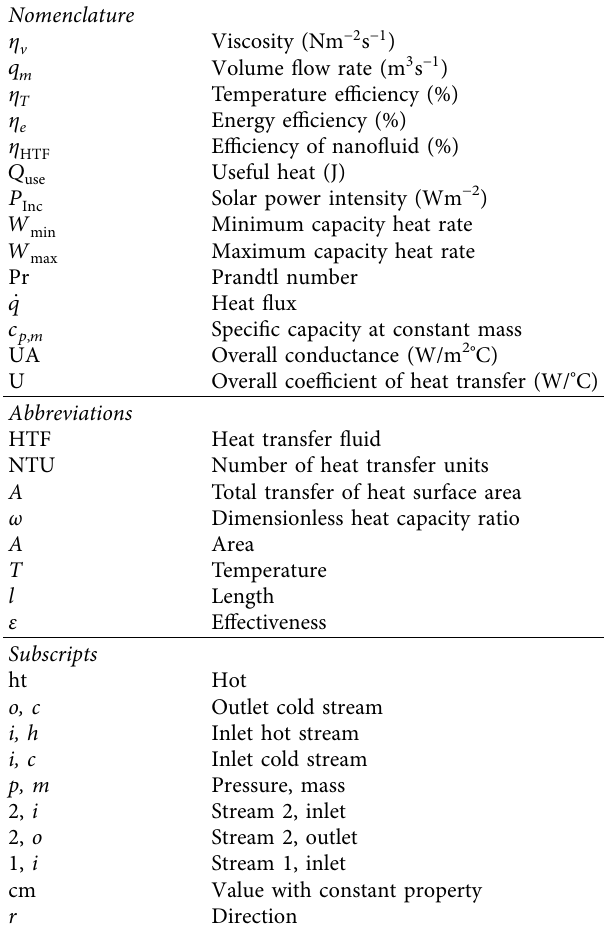
Table 1: Acronyms, abbreviations, and subscripts.